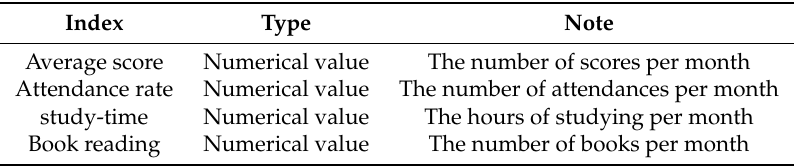
Table 2. Evaluation indexes of learning performance.